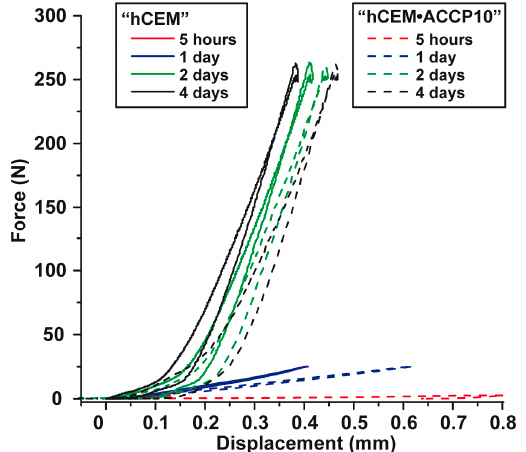
Figure 6. Mechanical properties (load-force) of the cement samples “hCEM” and “hCEM • ACCP10”. After the indicated incubation periods, 5 h (the graphs are close to the abscissa), 1 day, 2 days and 4 days, the displacement of the samples was compared between “hCEM” (solid lines) and “hCEM • ACCP10” (broken lines).